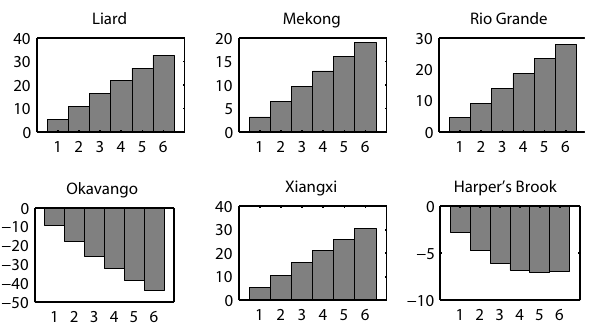
Fig. 3. Change in total-annual precipitation relative to baseline (ver- tical axis; %) for UKMO HadCM3 prescribed warming of 1–6 ◦ C (horizontal axis), for each